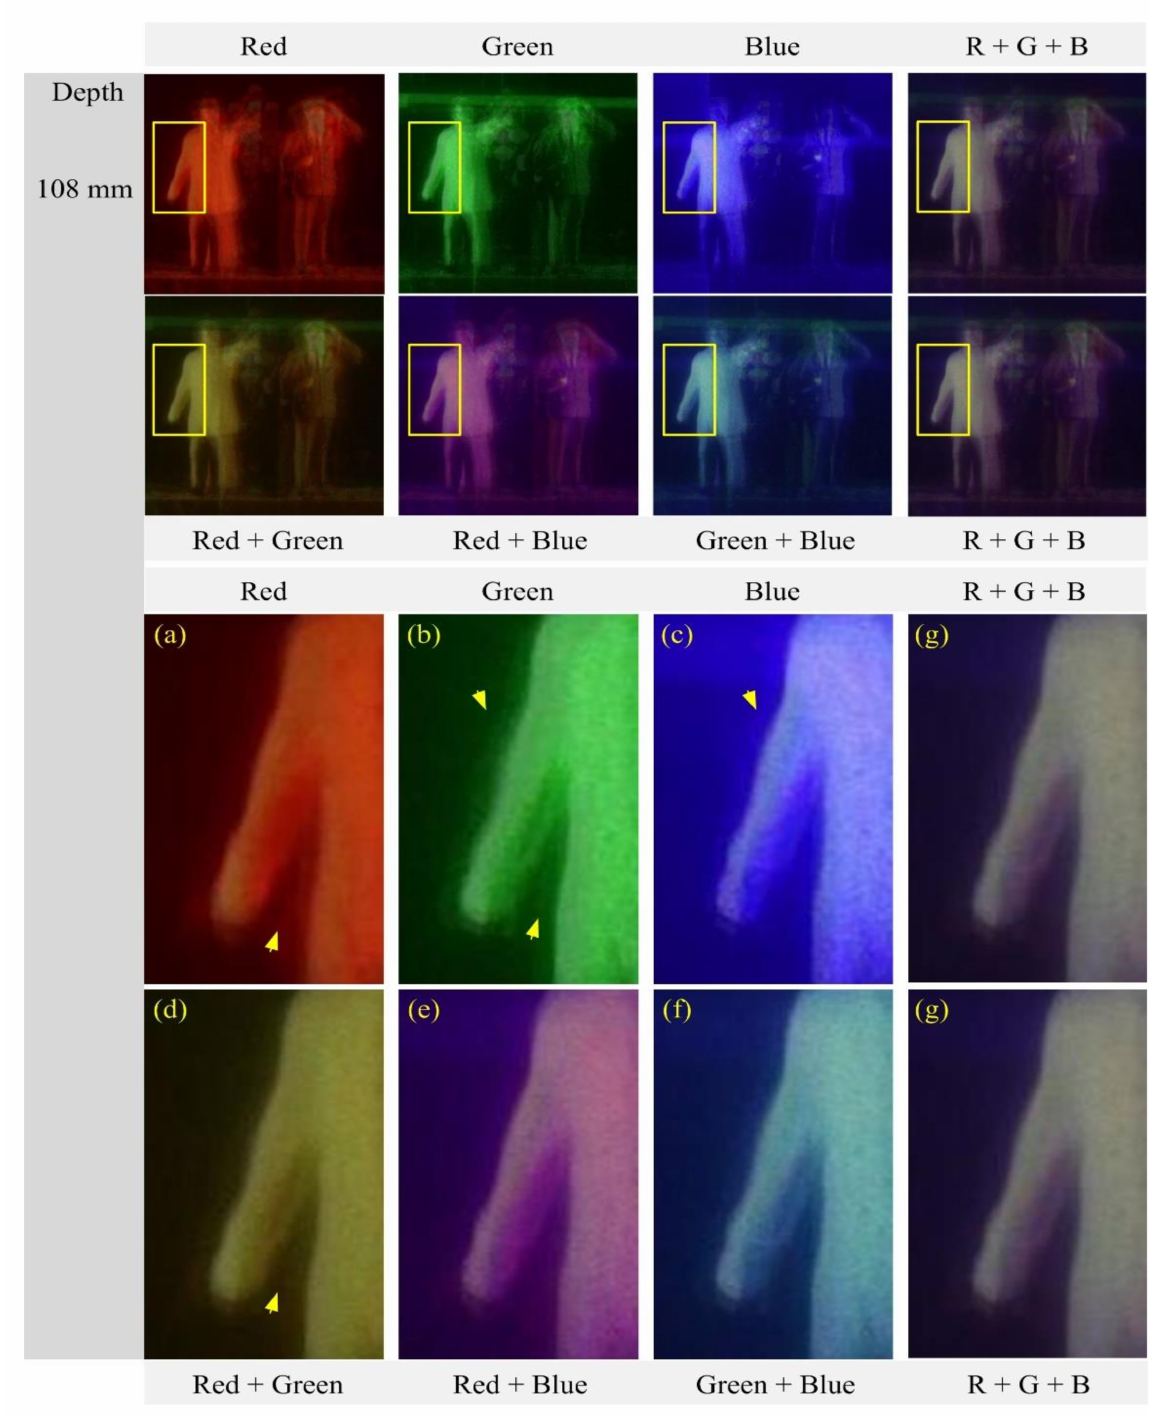
Figure 15. Reconstructed images and their zoomed versions for the human object at the depth z = 108 mm. ( a ) Red ( b ) Green ( c ) Blue ( d ) Red + Green ( e ) Red + Blue ( f ) Green + Blue, and ( g ) Red + Green + Blue